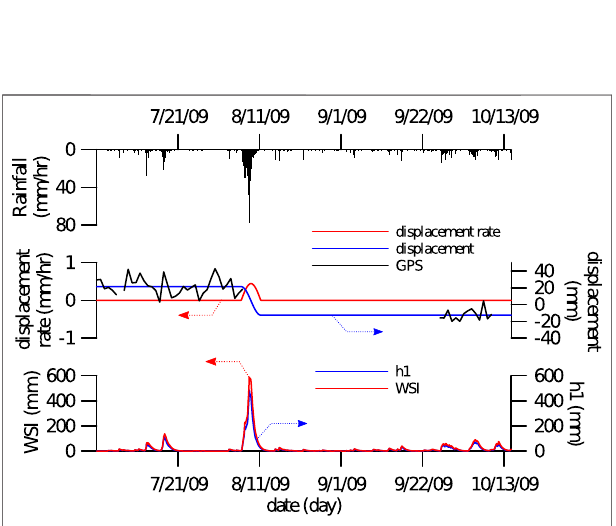
FIGURE 14 | Close-up time series plots of the 2009 Morakot rainfall- triggered SiangYang landslide. From the top panel: RI; middle: displacement, DR; bottom: h 1 and WSI. The DR is the negated time derivative of the GPS displacement. The light blue shaded line in the bottom panel indicates the WSI threshold inferred in the TienChih landslide.